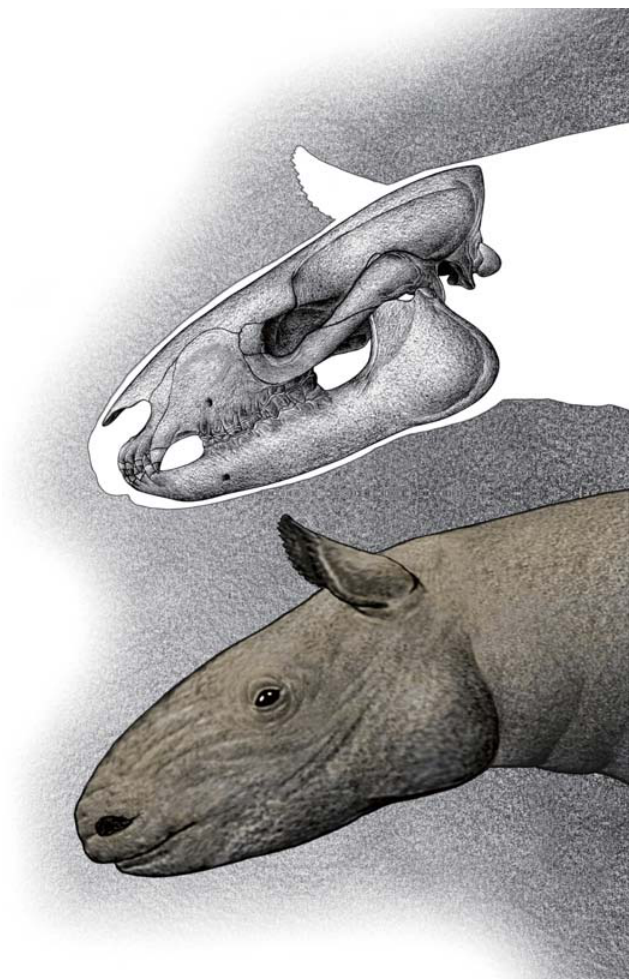
Fig. 6. Reconstruction of the skull of the paraceratheriid rhinocerotoid Pappaceras meiomenus H.B. Wang, Bai, Meng, and Y.Q. Wang, 2016, from the late Early Eocene of